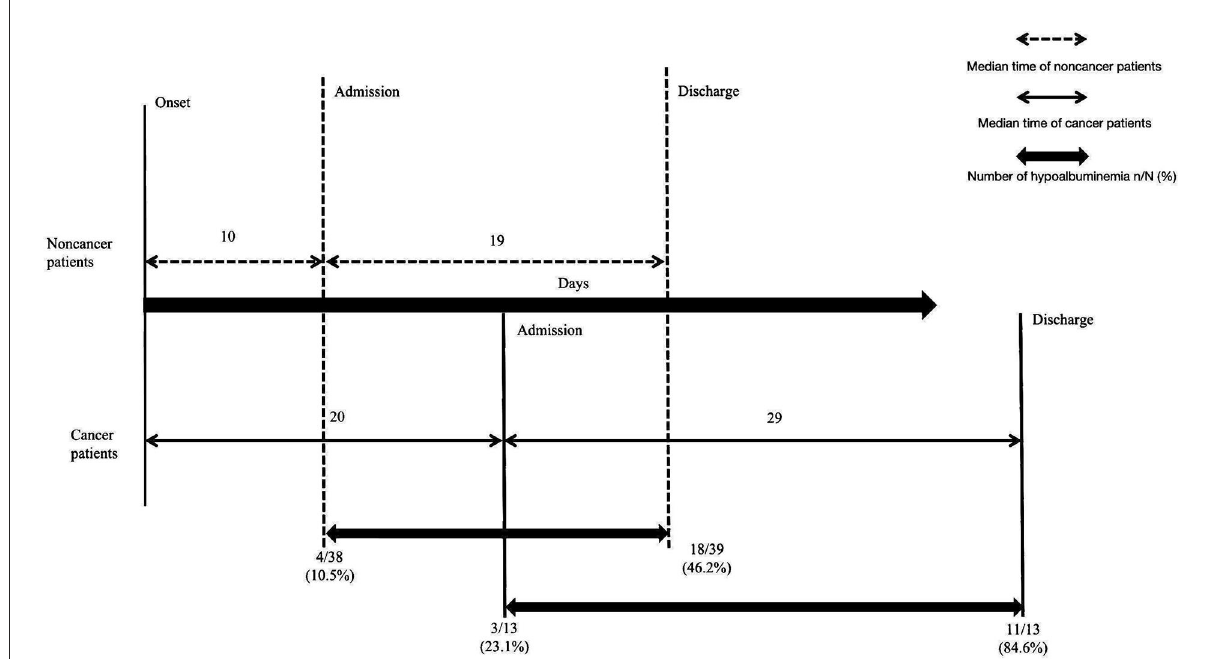
FIGURE1 The outcome discrepancy in COVID-19 patients with and without cancer. Compared with noncancer patients, cancer patients experienced a longer time from illness onset to hospital admission (20 days vs. 10 days, p = 0.271), a significantly longer median time of hospitalization with treatment (29 days vs. 19 days, p = 0.048) and a higher incidence of hypoalbuminemia complications (84.6% vs. 46.2%, p = 0.016). Data are expressed as n (%), or n/N